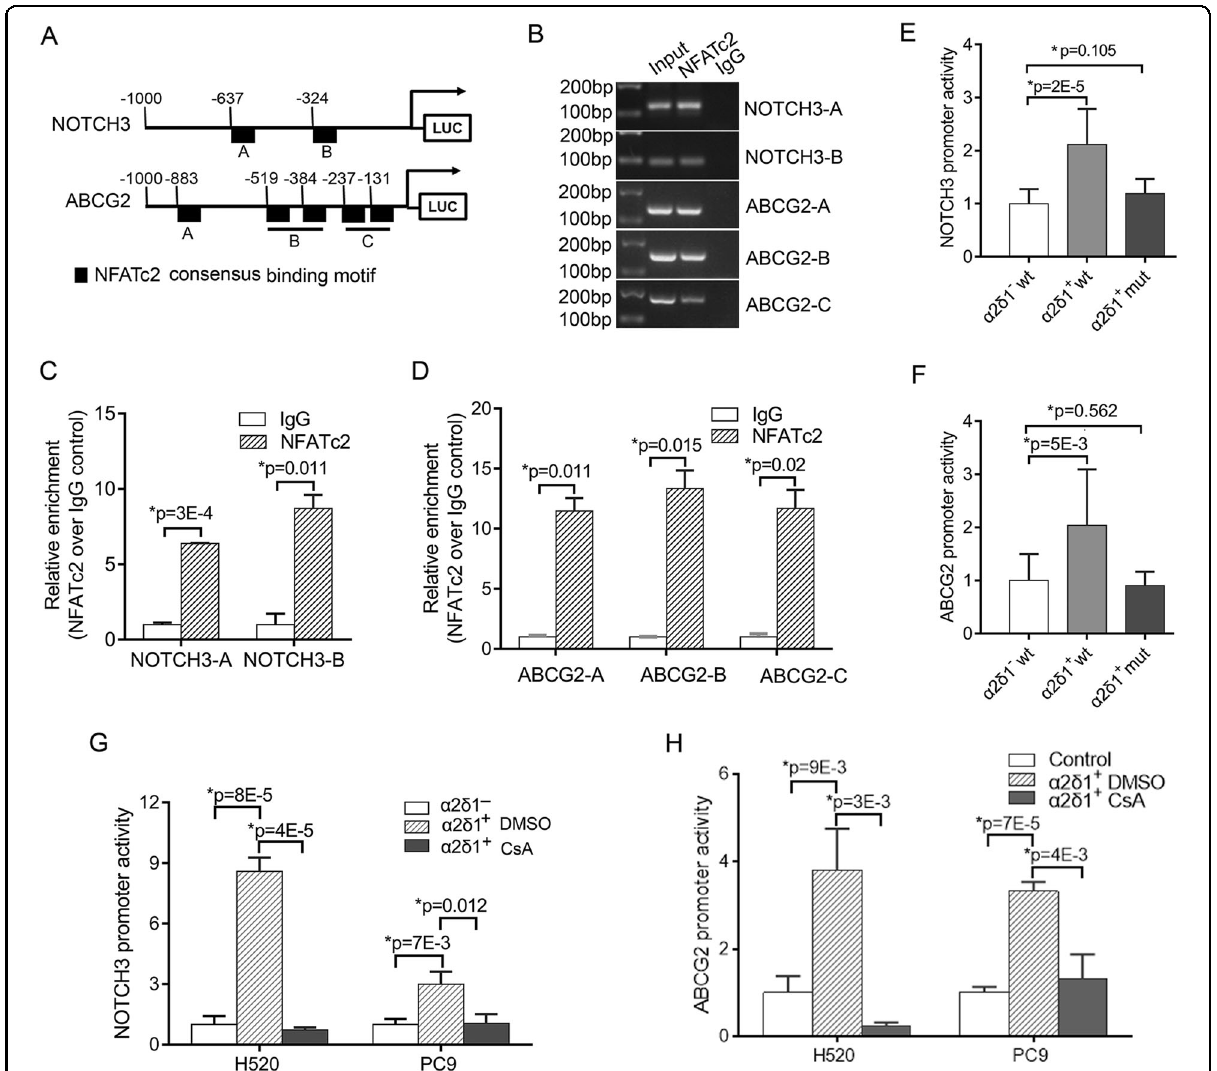
Fig. 7 NFATc2 activates the expression of NOTCH3 and ABCG2 by binding to their promoters. A Schematic depiction of the NOTCH3 and ABCG2 promoters that are fused to a luciferase reporter gene. B ChIP assay was performed using control IgG and anti-NFATc2 antibody in A549 cells. The precipitated DNA was ampli fi ed with primer pairs fl anking the putative NFATc2-binding regions of indicated promoters as depicted in ( A ) by PCR. C , D Quantitative analysis of NFATc2-binding to the indicated promoter regions of NOTCH3 and ABCG2 was determined by ChIP assay followed by qPCR. E , F The luciferase activities of NOTCH3 and ABCG2 reporters in the indicated cell fractions. The indicated reporters with wild type or mutant NFATc2-binding consensus sequences were co-transfected with PRL-TK plasmid, which serves as an internal control, into sorted α 2 δ 1 − and α 2 δ 1 + A549 cells. Luciferase values were normalized to Renilla reporter activities. G , H The luciferase activities of wild type NOTCH3 and ABCG2 reporters in the indicated cell fractions treated with control vehicle DMSO or CsA (1 µmol/L). All data are presented as mean ± SD of three independent experiments ( n = 3). *Student ’ s t